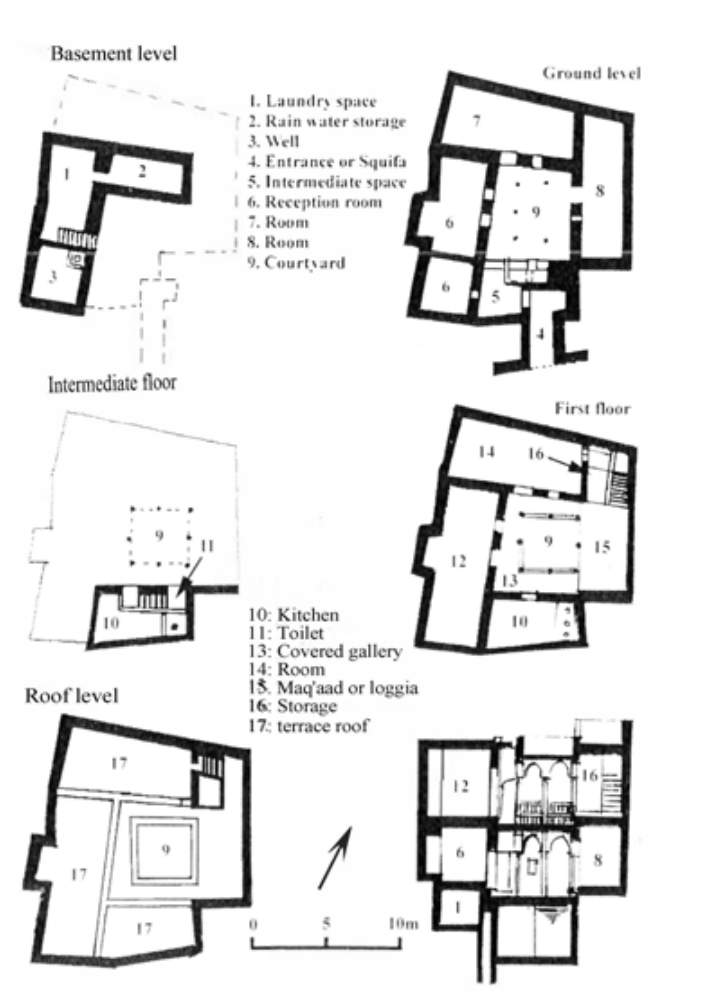
Figure 1. : A basic courtyard house in theCasbah in Algiers (Golvin, 1988)